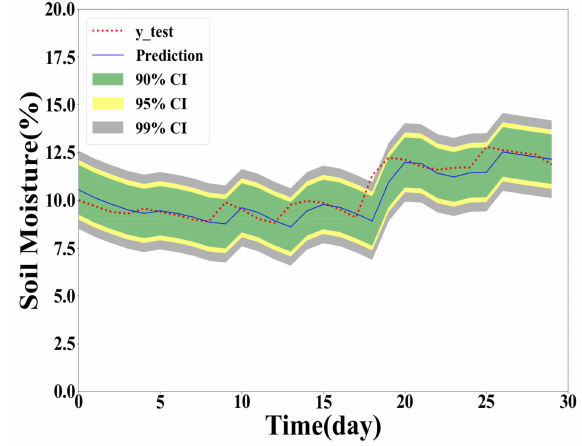
Figure 13. Y(1) prediction with full training data and testing in test Sep.